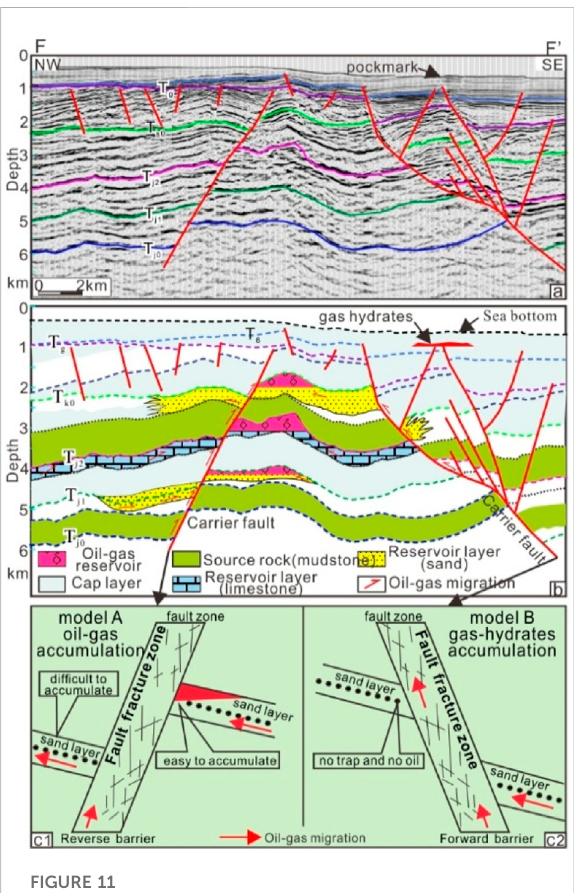
FIGURE 11 Oil – gas accumulation model within DS-A